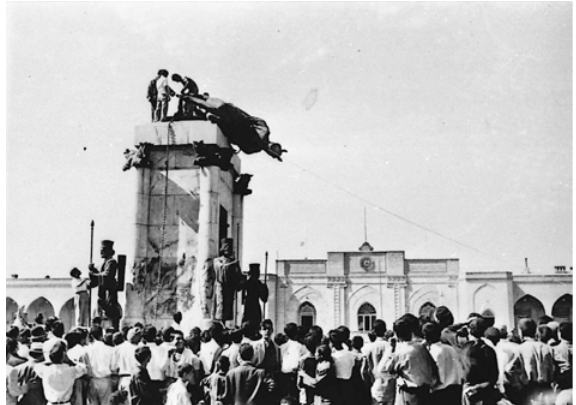
fig. 5. Drawing Pulling down the statues of reza Shah Pahlavi (r. 1925–1941) in Sepah Square (currently Imam Khomeini Square, also called Toopkhaneh Square which is literally means artillery Square), Tehran’s main square, 18 august